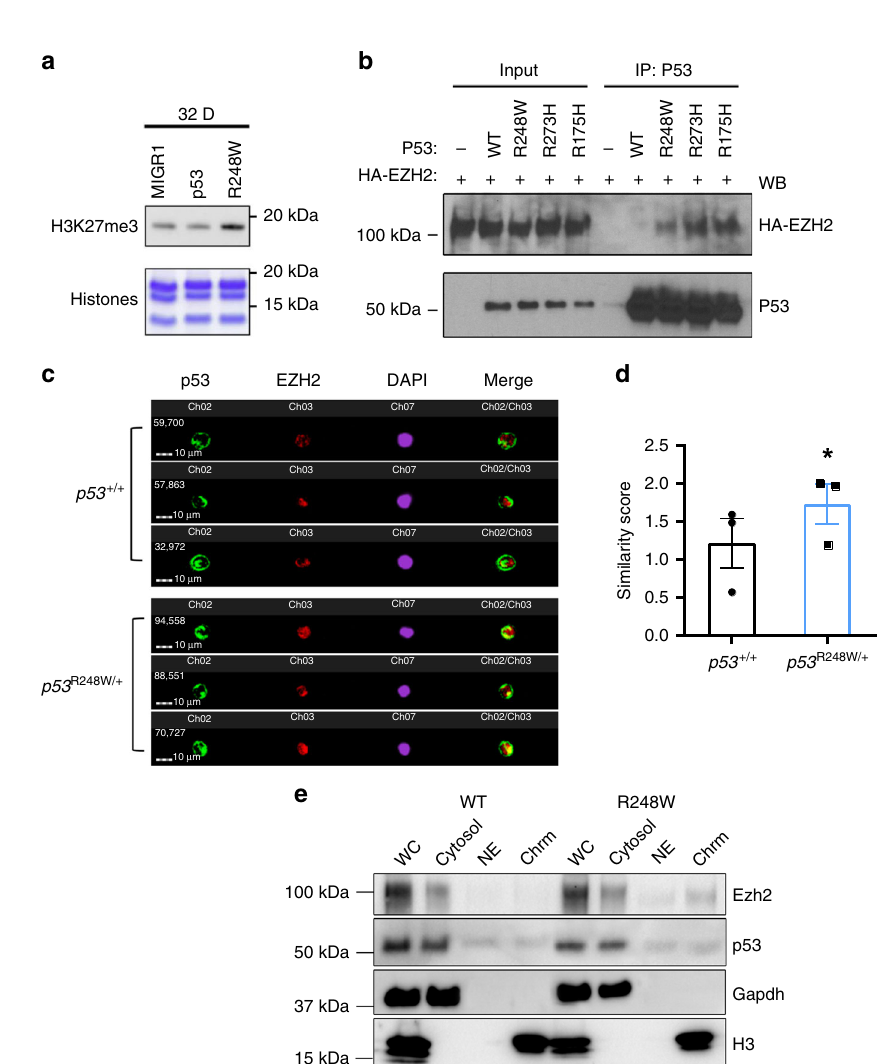
Fig. 4 EZH2 targets were signi fi cantly downregulated in p53 mutant HSPCs. a Quantitative reverse transcription polymerase chain reaction (RT-PCR) analysis of mRNA levels of p53 target genes, including p21 and Necdin , in HSCs; n = 3 biological replicates. b Gene Set Enrichment Assays (GSEA) analysis shows that EZH2 targets were signi fi cantly downregulated in p53 mutant HSPC compared to p53 + / + HSPCs. c p53 mutant HSPCs display increased levels of H3K27me3 (trimethylation at lysine 27 of histone H3) determined by immuno-blot analysis. d Lineage depleted HSPCs were stained with SLAM (signaling lymphocyte activation molecule) surface markers (CD48 and CD150) before fi xation. Median fl uorescence intensity of H3K27me3 in p53 + / + and p53 R248W/ + HSCs (Lin − Sca1 + Kit + CD48 − CD150 + cells) was detected by ImageStream fl ow cytometry analysis. p53 + / + n = 35 cells, p53 R248W/ + n = 52 cells. e H3K27me3 ChIP-seq (chromatin immunoprecipitation sequencing) tag density in p53 + / + and p53 R248W/ + HSPCs, centered on TSS (transcription start site). f Heat map shows genes in HSPCs marked by H3K27me3. g Genome browser views of H3K27me3 ChIP-seq pro fi les of Cebp α (CCAAT/enhancer-binding protein alpha) and Gadd45g (growth arrest and DNA-damage-inducible 45 gamma). h H3K27me3 enrichment on Cebp α and Gadd45g genes in p53 + / + and p53 R248W/ + HSPCs were examined by H3K27me3-ChIP assays; n = 3 independent experiments. i Quantitative RT-PCR analysis of mRNA levels of Cebp α in p53 + / + and p53 R248W/ + LT-HSCs; n = 3 biological replicates. j Quantitative RT-PCR analysis of mRNA levels of Gadd45g in p53 + / + and p53 R248W/ + LT-HSCs; n = 3 biological replicates. Data are represented as mean ± SEM. P -values were calculated using unpaired t test with Welch ’ s correction in a and d , paired t -test in h , i , and j , and GSEA software in b ; *P < 0.05, *** P < 0.001. Source data are provided as a Source Data fi le.